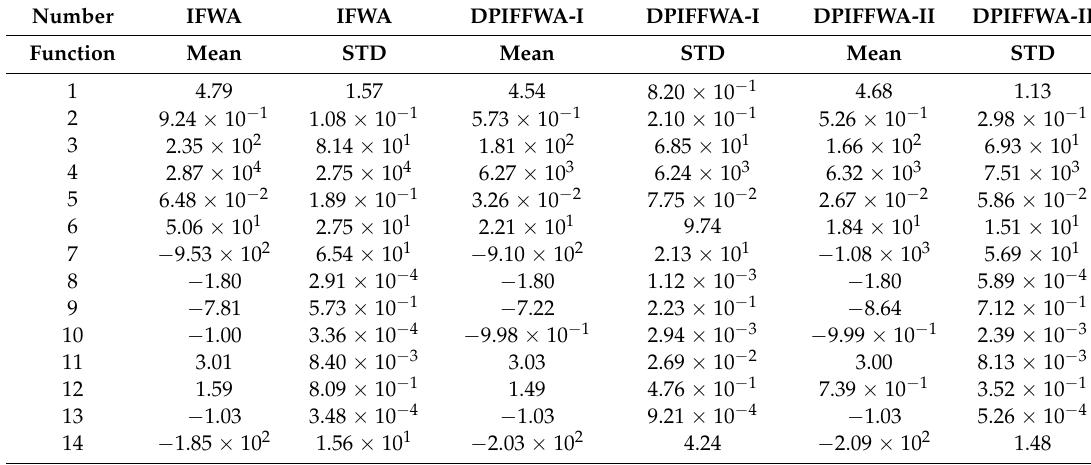
Table 8. Means and standard deviations of the fourteen benchmark functions with SI = 1. IFWA = Iterative Fireworks Algorithm.